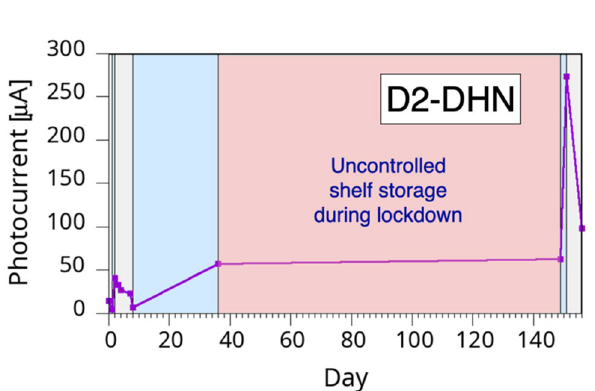
Figure 8. Temporal evolution of the photocurrent generation in a D3-DHN sample. The grey and light blue areas indicate dry and wet storage environment, respectively.